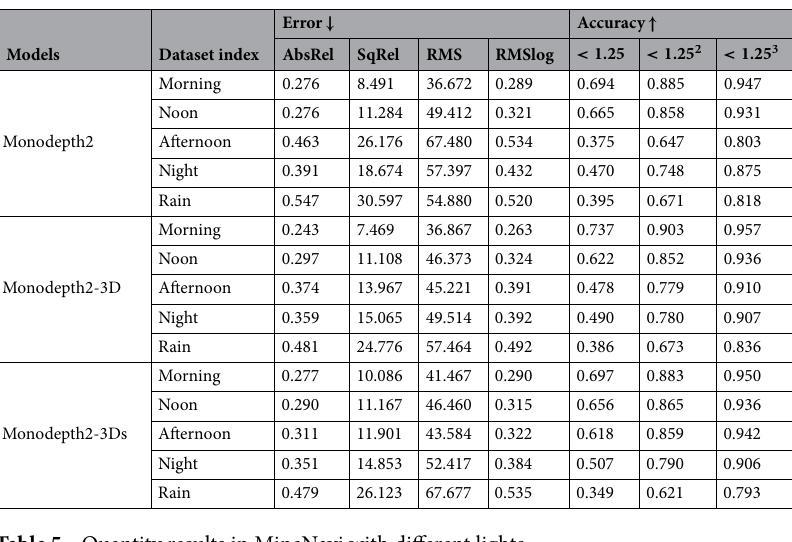
Table 5. Quantity results in MineNavi with different lights.